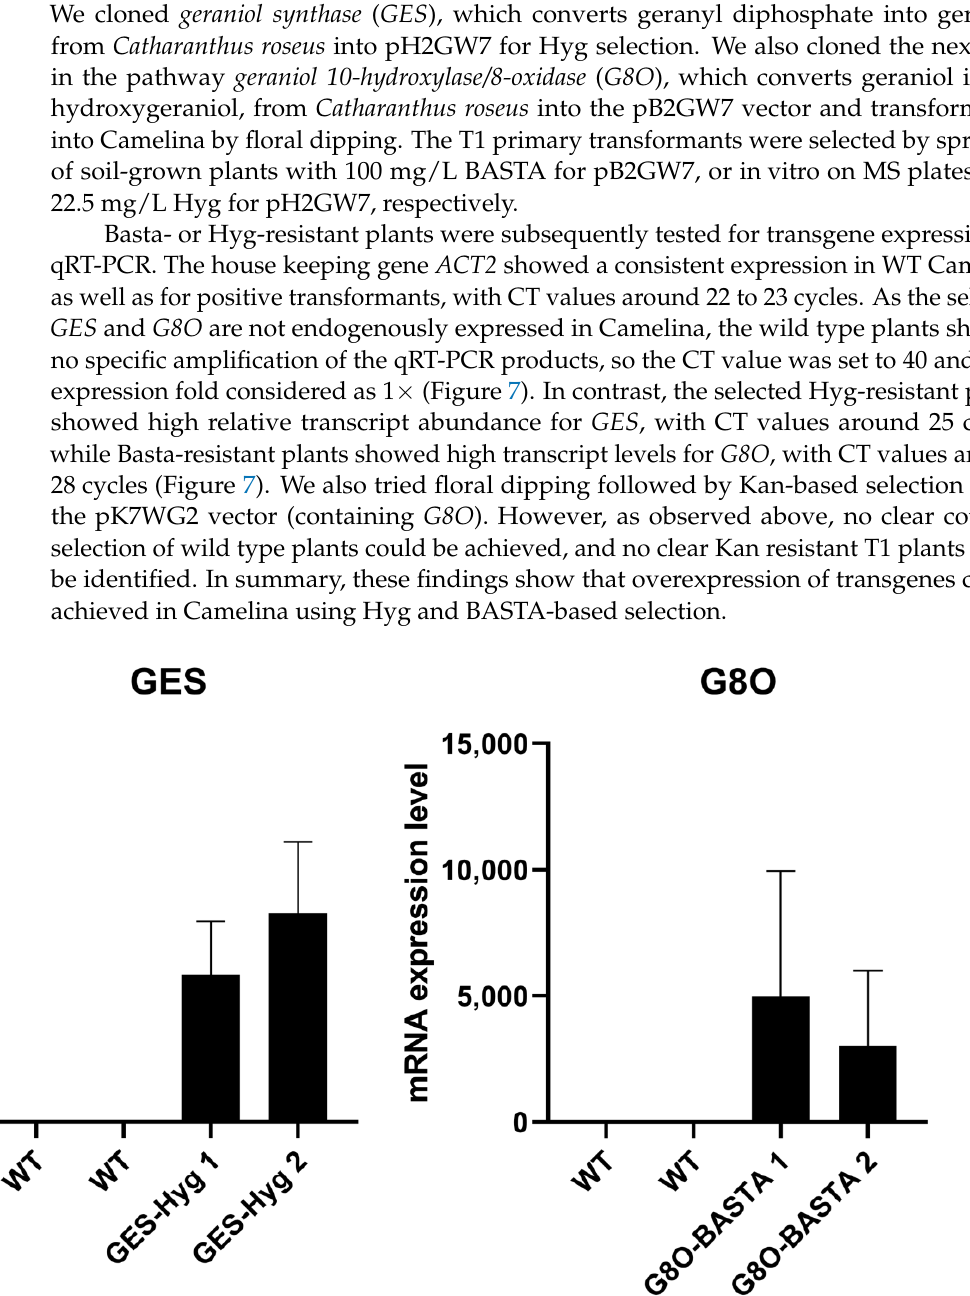
Figure 7. GES and G8O relative mRNA expression to WT in T1 Camelina transformants. GES and G80 are transgenes originating from Catharanthus roseus , while ACT2 is an actin gene from Camelina. Due to the lack of the transgene in WT, samples were normalised to WT. In both graphs two WT samples were used along with 2 positive transformants. The error bars represent standard deviation (SD) between samples. GES-Hyg 1 and GES-Hyg 2 are two plants which carry the GES gene along with a hygromycin resistance gene from the pH2GW7 backbone. G8O-BASTA 1 and G8O-BASTA 2 are two plants which carry the G8O gene along with a BASTA resistance gene from the pB2GW7